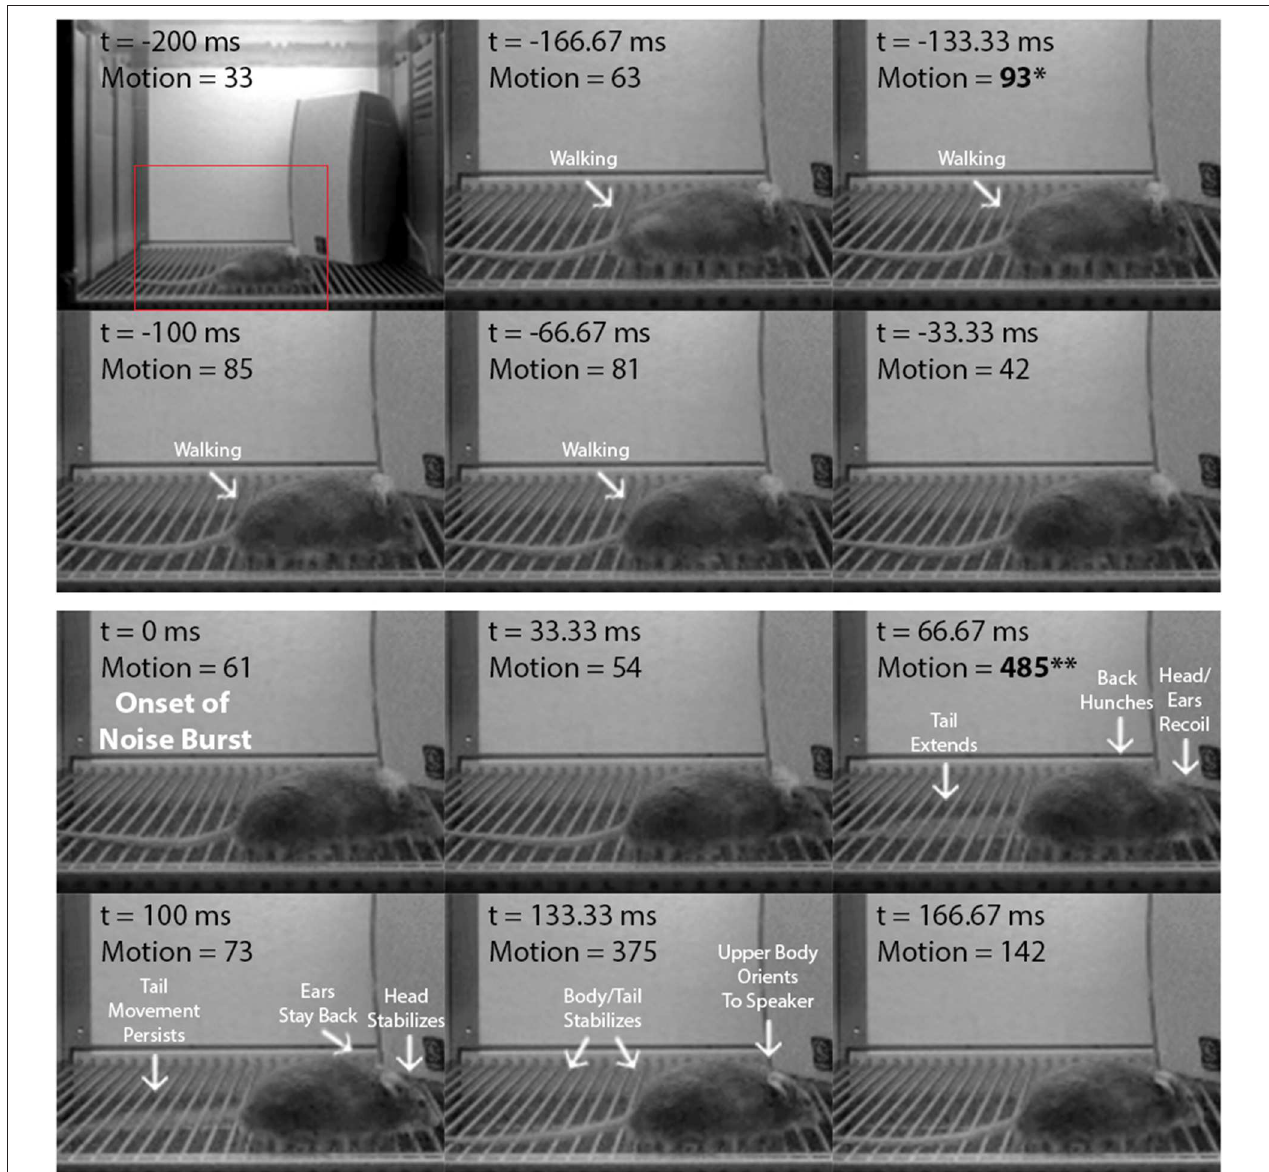
FIGURE 2 | The startle response as captured by VideoFreeze. Frame-by-frame video still images showing a mouse from 200ms before to 200ms after the onset of the 105 dB, 200ms white noise burst in the i/o experiment. Digital video was recorded at 30Hz, so each frame represents 33.33ms of video. Time (t) is relative to the onset of the noise burst ( t = 0ms). Motion represents the motion index score calculated by the VideoFreeze system. Top six frames include the 200ms before the onset of the noise burst (maximum motion index = 93au, indicated by asterisk) and bottom six frames include the 200ms after the onset of the noise burst (maximum motion index = 485au, indicated by double-asterisk). For this example, normalized startle amplitude (maximum motion index after minus before onset) = 392au. Before the noise burst, baseline activity was captured by motion indexes of ≤ 93au. At t = 66.67ms, there was a large spike in the motion index to 485au, and the startle response was observed and characterized by significant head, ear, back, and tail movements (body parts in motion appear blurry in image). At t = 100ms, the motion index decreased to 73au, as movement was observed in the tail only. The startle response concluded by t = 133.33ms.